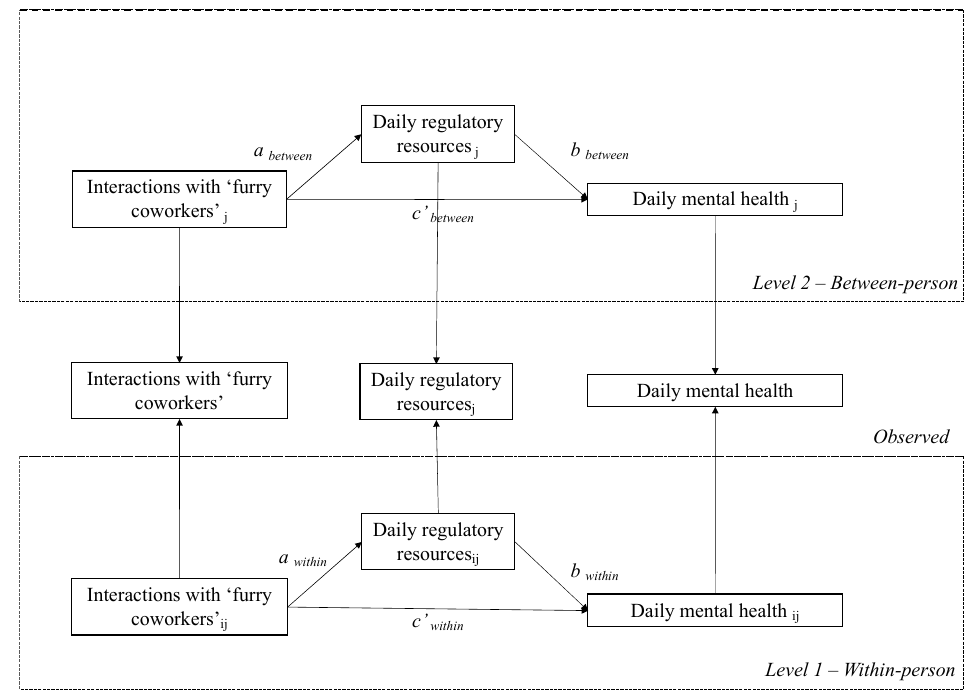
Figure 1. The conceptual model under study. For brevity, the control variables are not shown in the